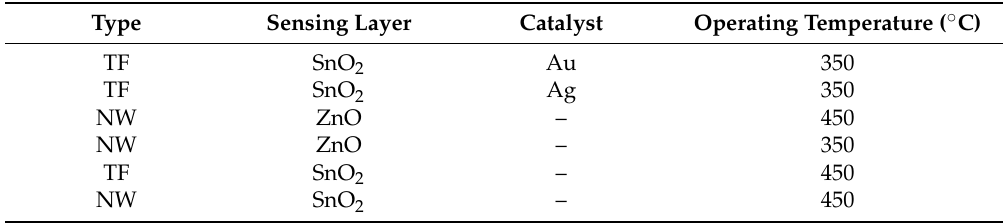
Table 2. Preparation and working data of the electronic device sensor array (TF = Thin Film, NW =